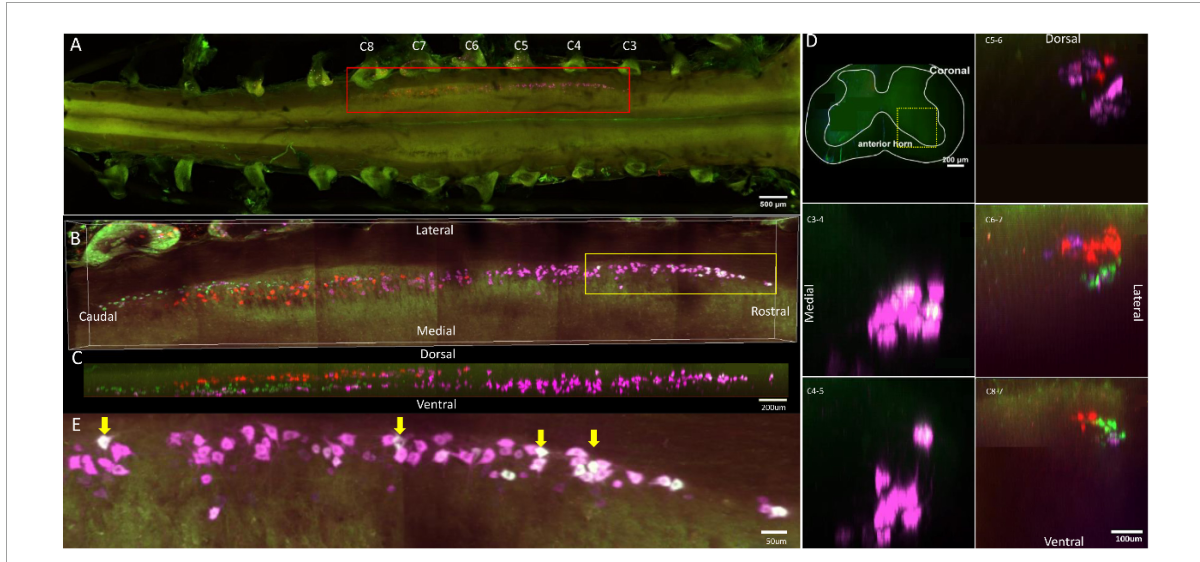
FIGURE1 Distribution characteristics of motor neurons targeting triceps (labeled by FG, red), extensor carpi radialis longus (labeled by CTb-647, purple), and extensor carpi ulnaris (labeled by CTb-488, green). (A) Spatial images of multi-tracks in a holistic view. (B,C) The relative spatial positions of the motor neuron columns targeting different muscles in sagittal and corona viewing angles. The yellow box that outlines the region of interest was shown in panel (E) . (D) The schematic diagram of the distribution of different motor neuron columns in the anterior horn of the spinal cord. The yellow box that outlines the region of interest is amplified in the subpanels in panel (D) . The cross-sectional images are maximum projections of different parts of the spinal cord. The motor neurons innervating triceps (red) have little overlapping with those of extensor carpi radialis longus (purple) and extensor carpi ulnaris (green). (E) Motor neurons, which innervate extensor carpi radialis longus and extensor carpi ulnaris, are some double-labeled. Yellow arrow: double-labeled motor neurons. White is the overlap between purple and green colors.